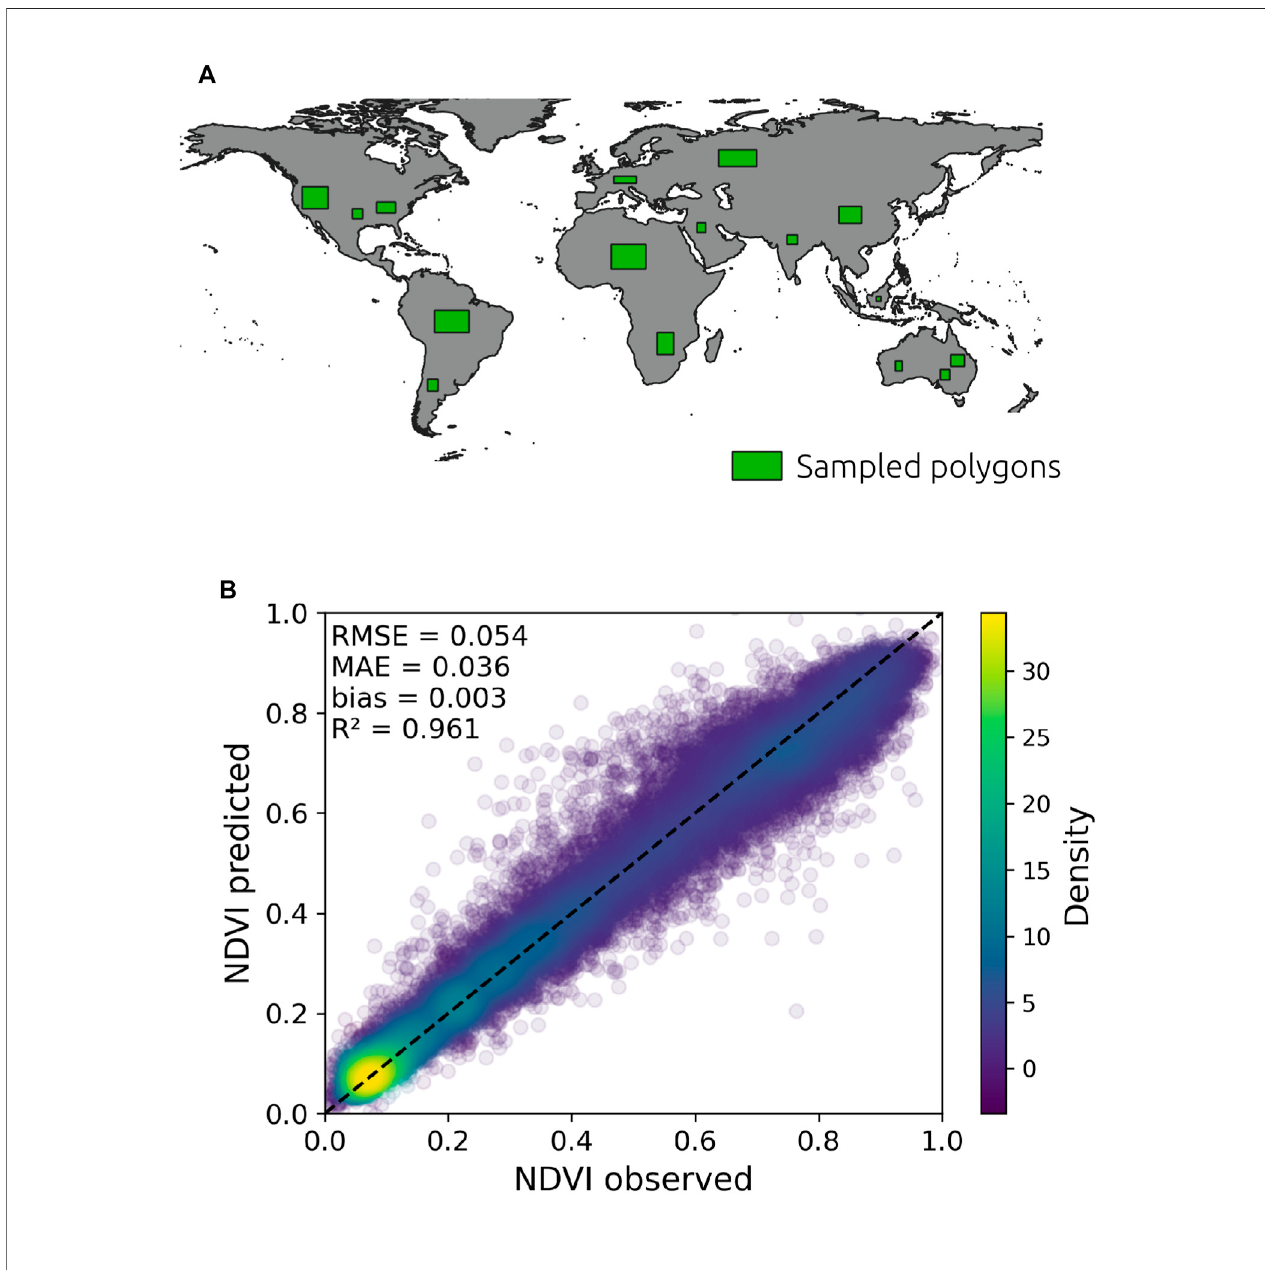
FIGURE2| ValidationofthecombinationoftheGIMMSAVHRR NDVIandMODIS NDVIusingmonthlyobservations ofGIMMSNDVIfrom2011to2013.Polygons where random samples were taken for validation are presented in the (A) , while the (B) shows a density scatter plot of the validation and associated statistics.